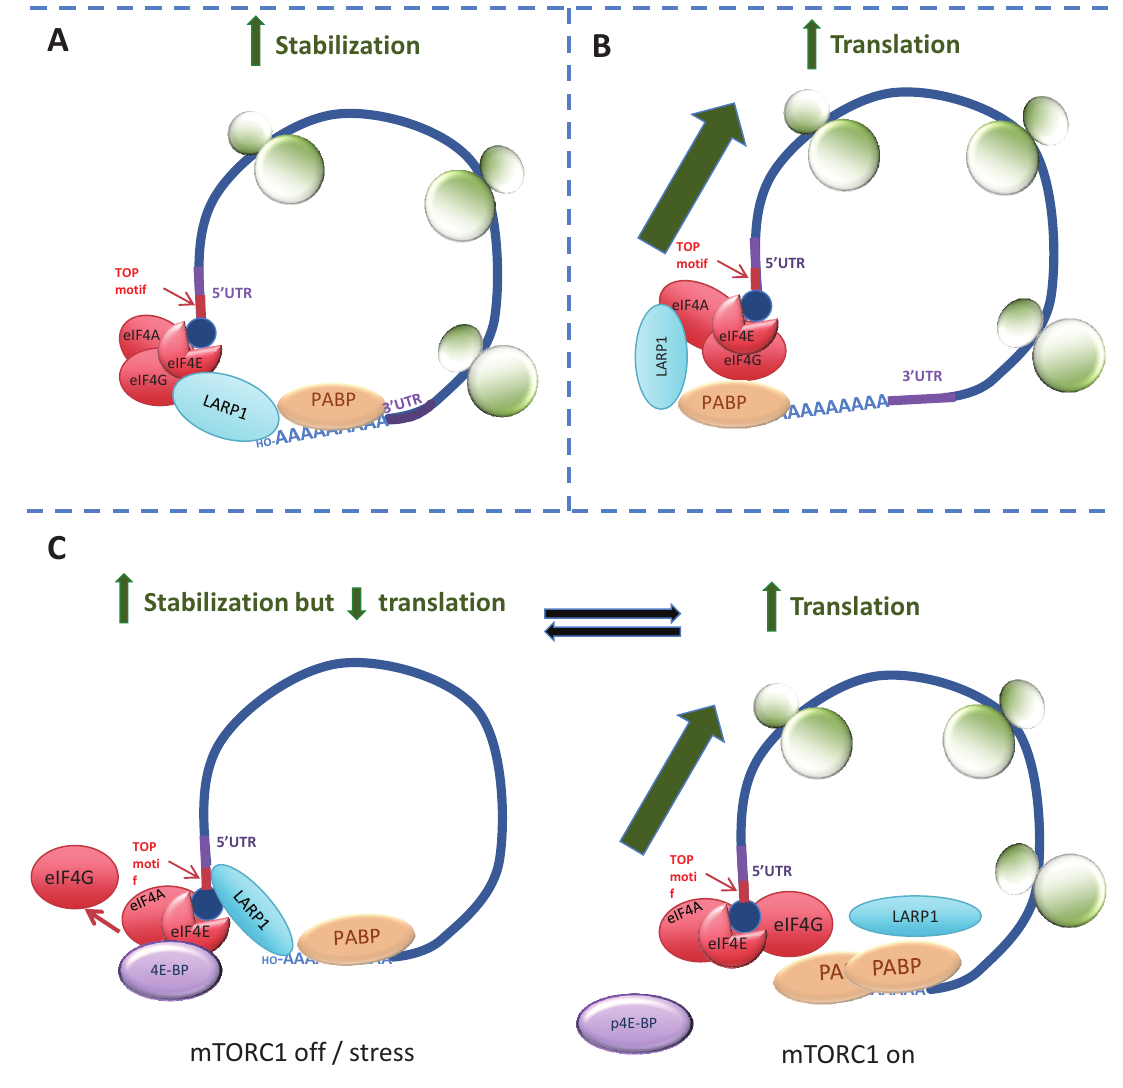
Figure 2. Proposed mechanisms for the interaction between LARP1 and 5'TOPs. ( A ) Aoki et al. (2013) [45] demonstrated that LARP1 independently binds the terminal adenosine of the poly(A) tail of mRNA and, by simultaneously interacting with 5'cap components, circularises mRNA of 5'TOP-bearing transcripts to enhance their stability; ( B ) Tcherkezian et al. (2014) [37] showed LARP1 as associating with 5' cap components via its interaction with PABP. LARP1 is complexed with Raptor, which enhances 5'TOP translation, but it is unclear whether this is functionally distinct from its association with